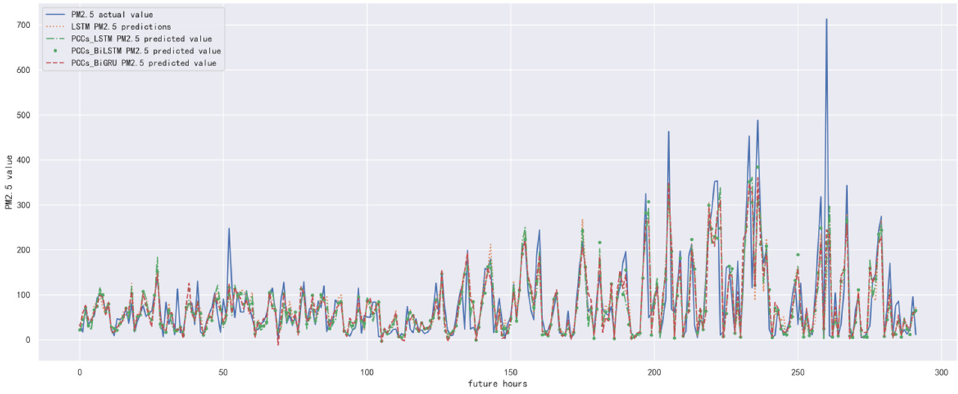
Figure 15. The schematic diagram of predicted PM 2.5 concentration in the next six hours. Table 5. The MAE of PM 2.5 concentration prediction in the next six hours.